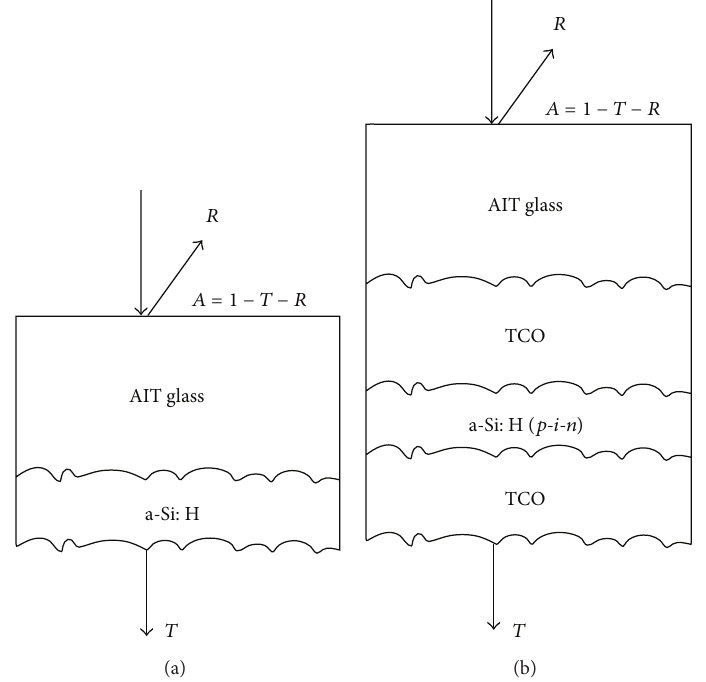
Figure 2: Schematic of the investigated structures on textured glass (not to scale). (a) a-Si:H layer on AIT glass, (b) solar cell precursor on AIT